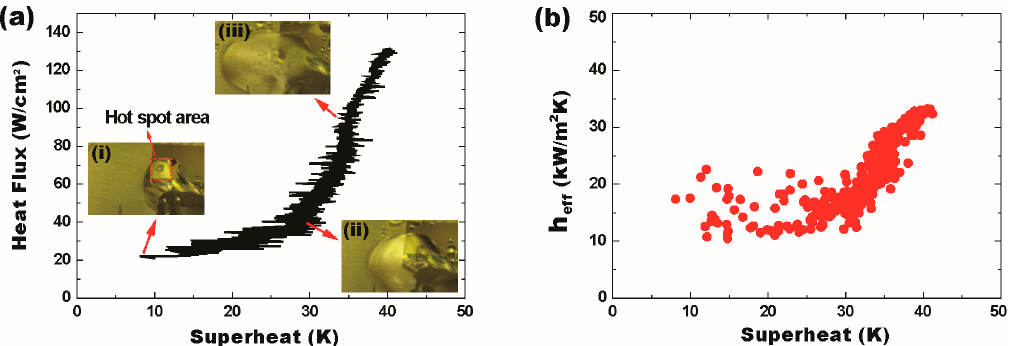
Figure 7. High-heat-flux thermal modulation by the SDMF platform. ( a ) Coolant droplets keep being injected and delivered to cool down the superheat of the target hot spot as low as 40 °C at the heat flux of 131 W/cm 2 . The insets represent the video snapshots of the nucleate boiling process at different heat flux regions of ( i ) 20 W/cm 2 ; ( ii ) 45 W/cm 2 ; and ( iii ) 90 W/cm 2 ; ( b ) The SDMF approach is able to stably manage the effective heat transfer coefficient at a high heat flux regime over 130 W/cm 2 .